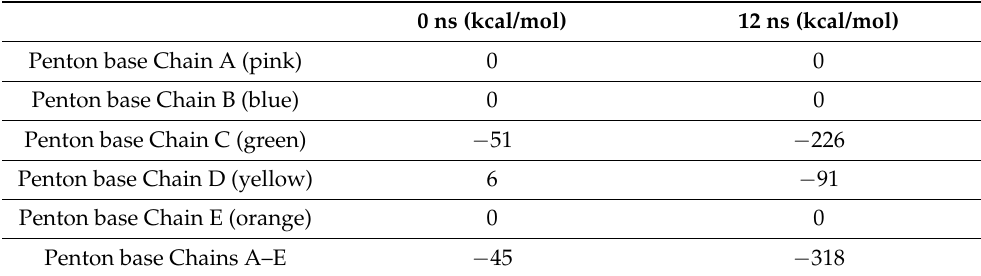
Table 2. Total non-bonded interaction energy between C4b and penton base for model 2 with covalent linkage to penton base Arg347. 0 ns (kcal/mol) 12 ns (kcal/mol) Penton base Chain A (pink)